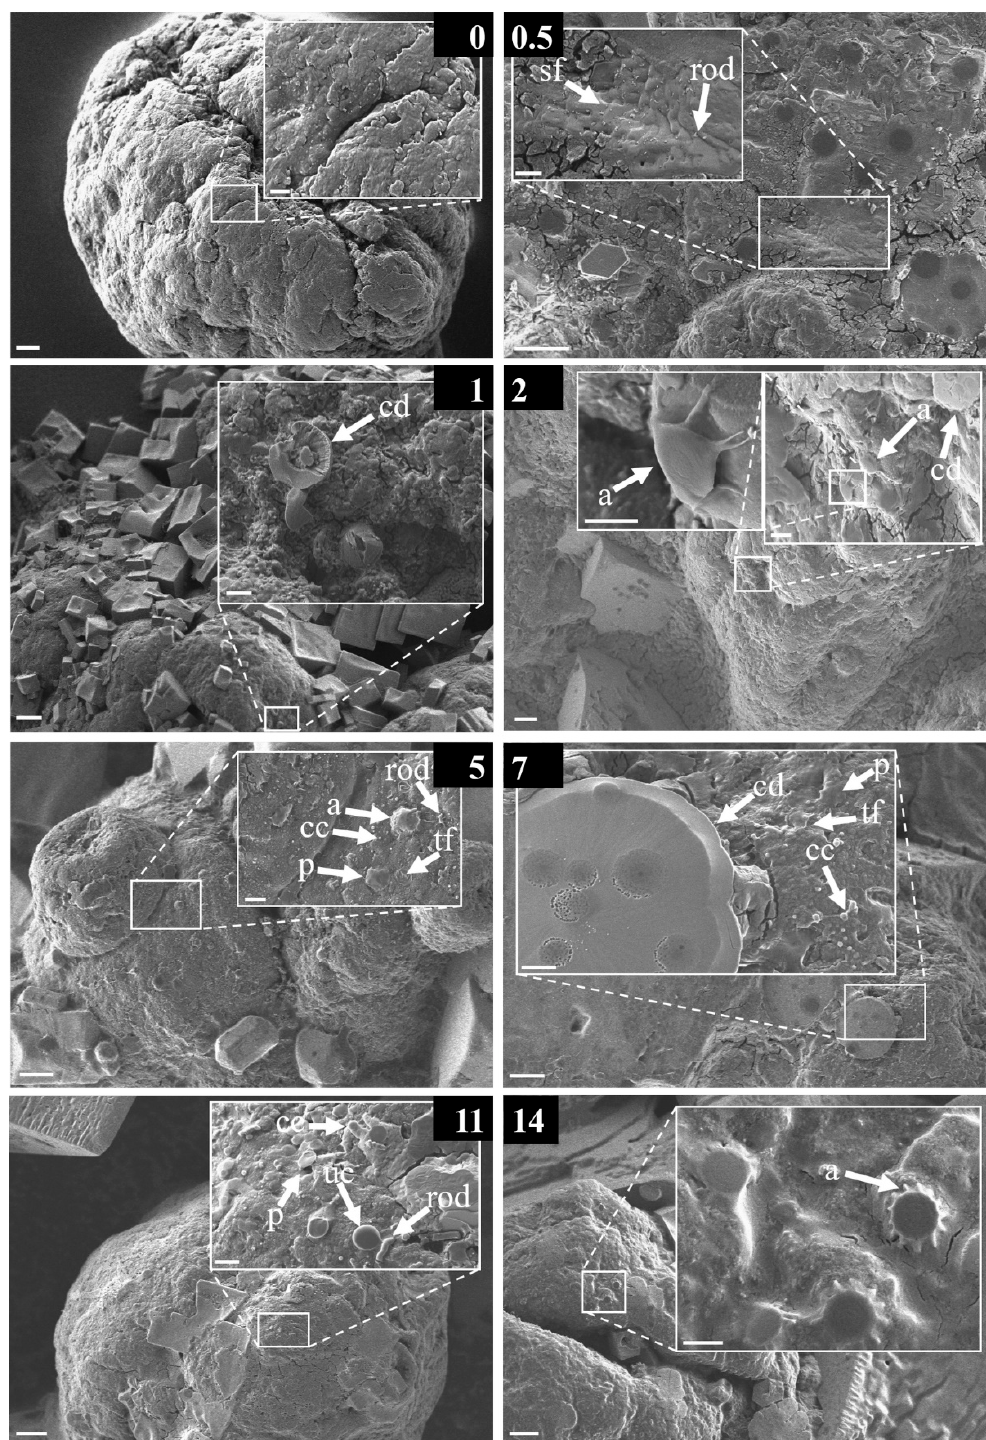
Figure 9. Scanning electron microscopy images of PVC incubated in seawater. Numbers in black boxes indicate incubation times in days (0 = raw material, 0.5 = half day, 1 = one day, 2 = two days, 5 = five days, 7 = seven days, 11 = eleven days, 14 = 14 days of incubation). Microorganismal structures are highlighted with arrows. a = non-assignable structure, rod = rod / vibrio-shaped bacteria, cc = coccoid bacteria, cd = centric diatom, p = platelet structure, sf = solid film, tf = thin film, uc = unicellular structure. Scale bar: Large image 10 µm, magnified image 2 µm.